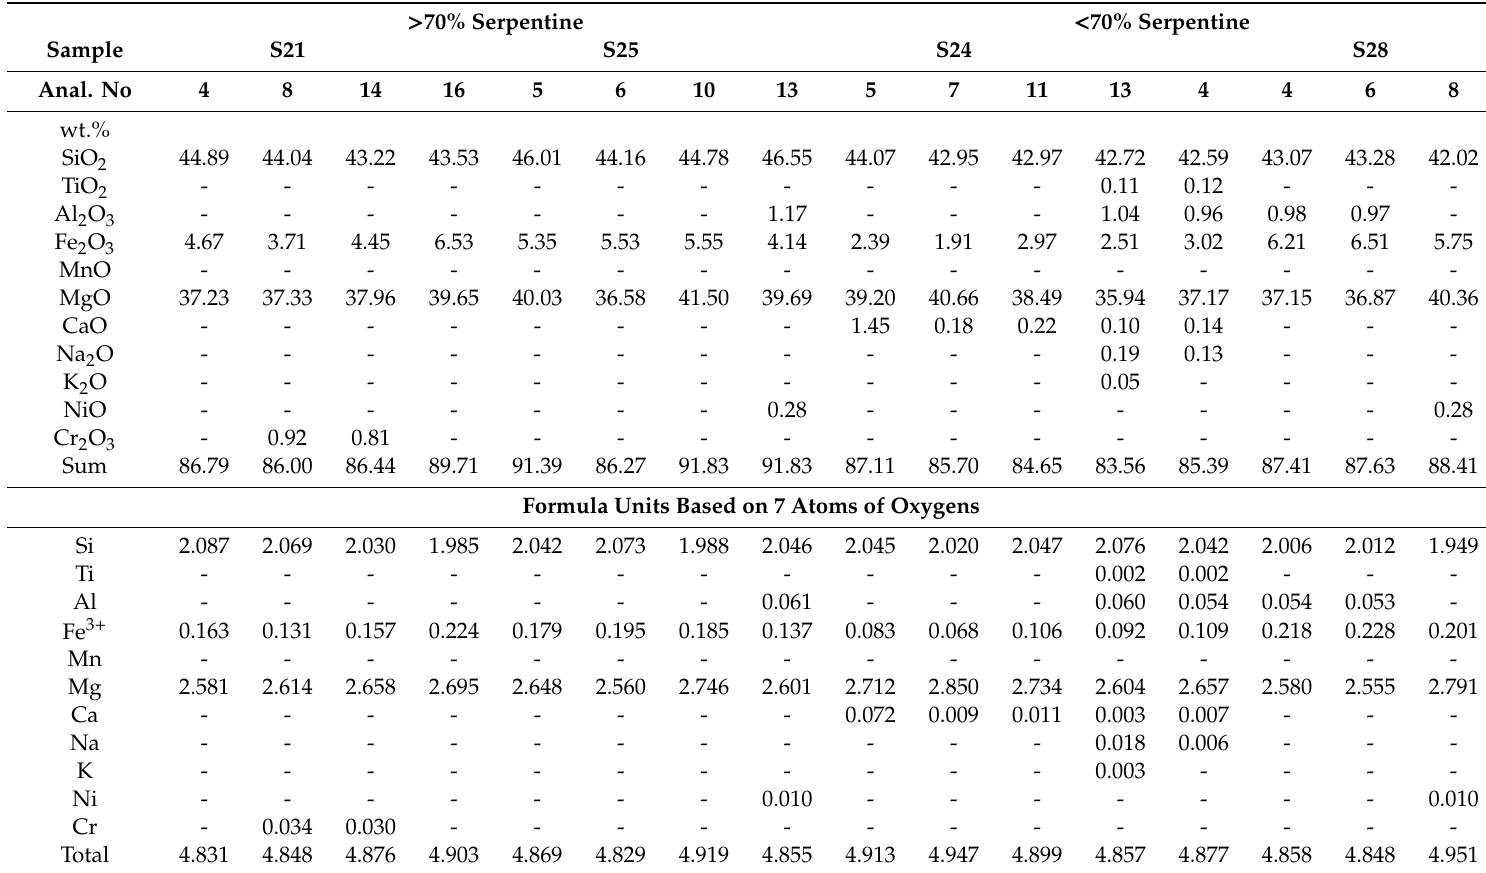
Table 3. Representative electron microanalyses of serpentine minerals from examined ultramafic rocks (-, below detection limit). > 70% Serpentine < 70%